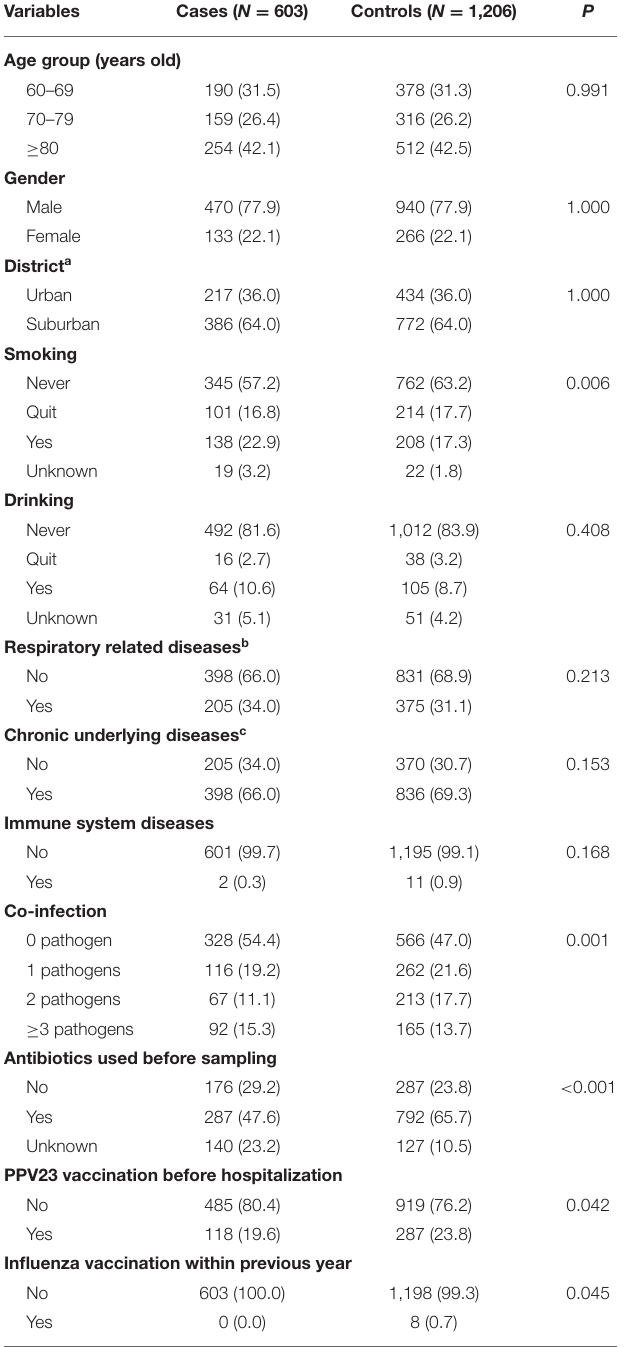
TABLE 1 | Basic characteristics of research objects by pneumococcus positive patients (cases) and pneumococcus negative patients (controls).